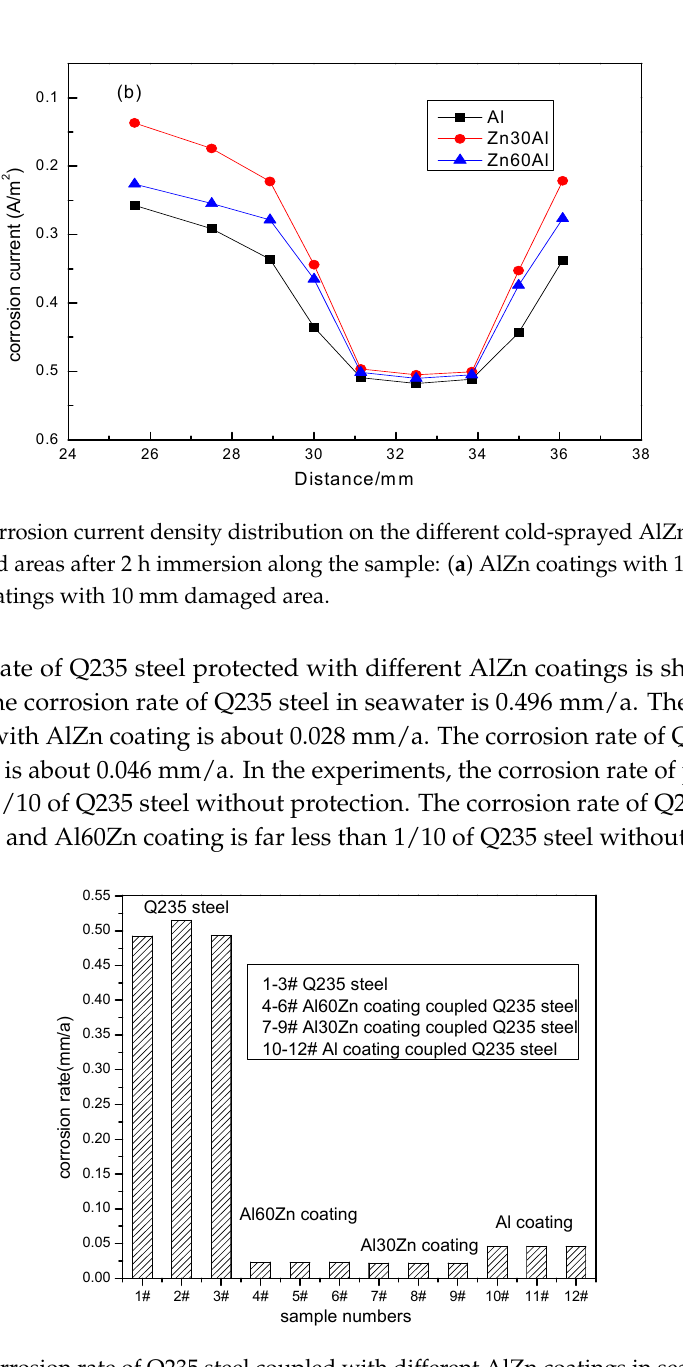
Figure 12. The corrosion rate of Q235 steel coupled with different AlZn coatings in seawater after 30 days immersion.